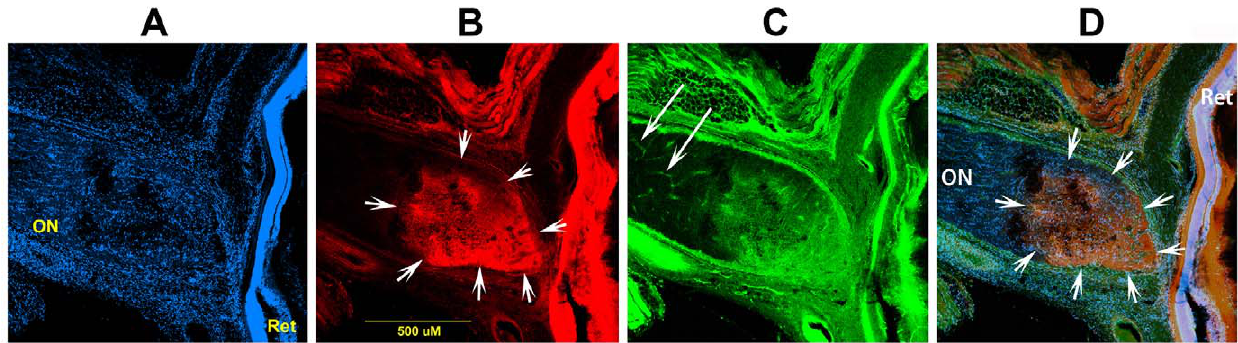
Figure 5. Confirmatory analysis of BBB breakdown in the anterior ON using low- and high-MW dyes. A. DAPI-counterstaining of the retina-ON junctional region. The ON and retina (Ret) are indicated. B. Rhodamine-3 kDa dextran label. Strong signal is present only in the anterior ON (the area of infarct; indicated by arrows), and the overlying retina. C. FITC-BSA label. The FITC signal is present in isolated capillaries in the posterior ON (long arrows), as well as a diffuse signal in the infarct region. D. Merged image, showing diffuse dextran-rhodamine and FITC-BSA signal overlap. Scale bar: 50 microns.